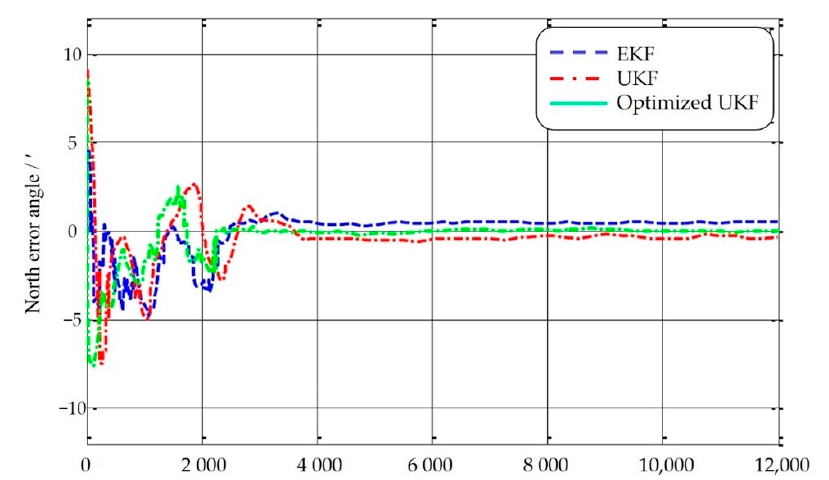
Figure 5. Filtering results of north error angle.